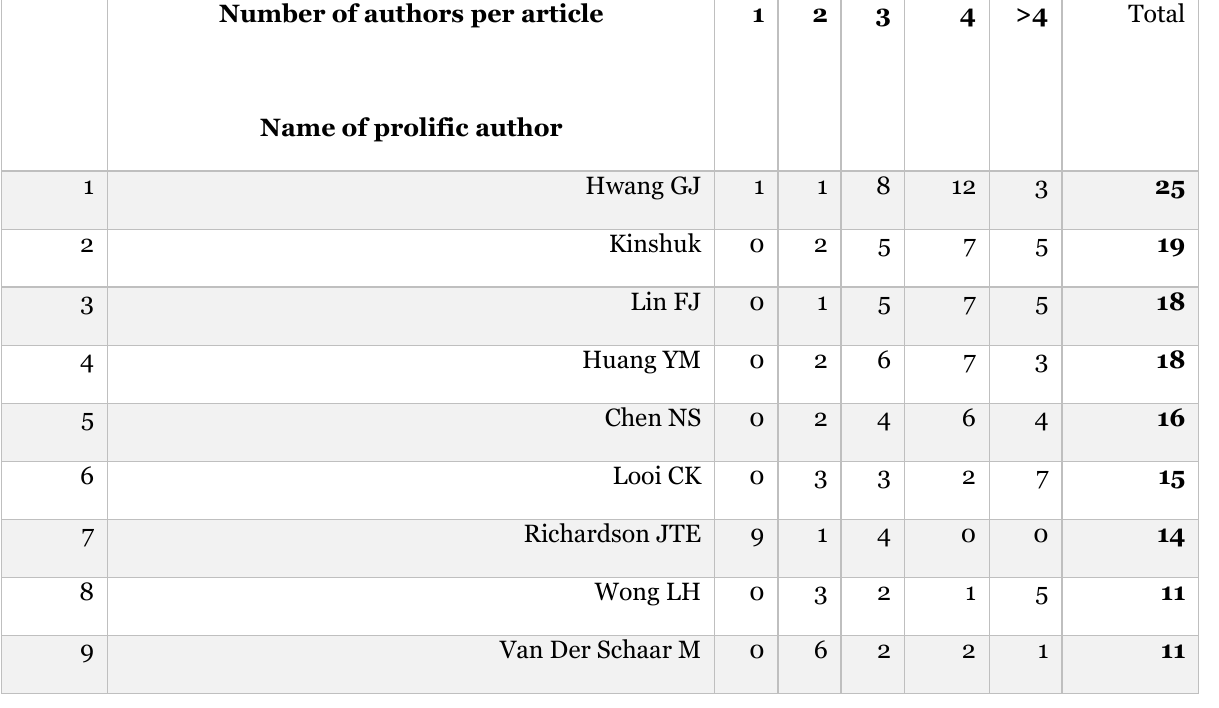
Collaboration Rate of Prolific Authors in